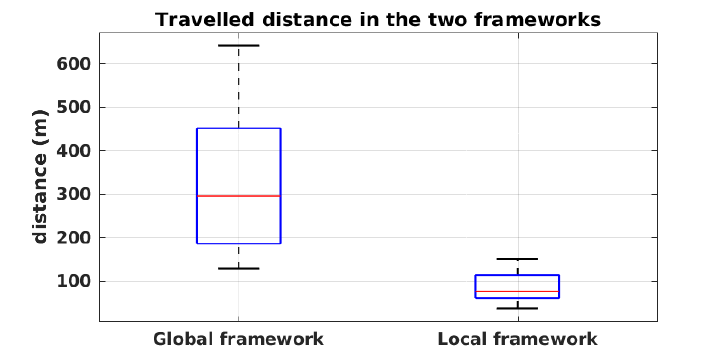
Figure 15. Travelled distance in simulation for the environmental condition C in both